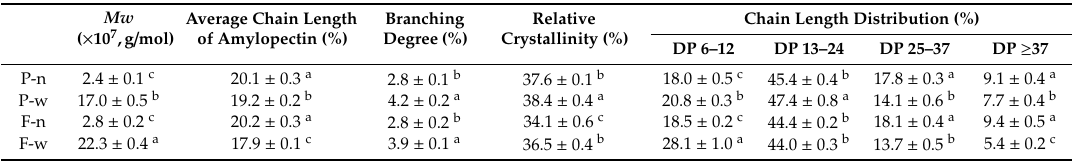
Table 3. The weight-average molar mass ( Mw ), amylopectin chain length distribution, α -1,6 linkage percentage, and relative crystallinity of starches.